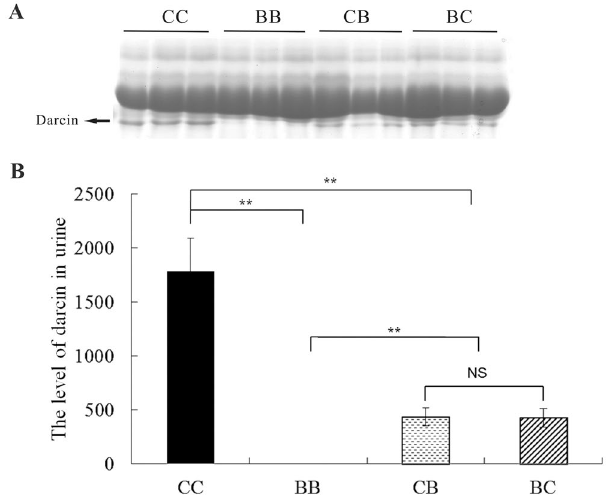
Figure 3. SDS-PAGE of urine from F1 progeny. ( A ) Representative image, darcin is indicated by an arrow; ( B ) Band intensities of darcin from the SDS-PAGE were quantified using the Image J program. The data are represented as mean ± SE, n = 8 in each group. ** Indicates significant difference of values at P < 0.01 by Student’s t test. BB: BALB/c strain; CC: C57BL/6 strain; BC: hybrid of BALB ♀ × C57 ♂ ; CB: hybrid of C57 ♀ × BALB ♂ ; NS: not